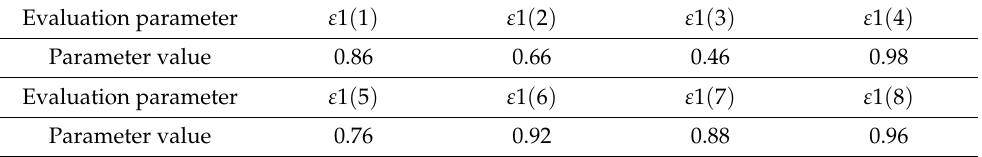
Table 1. Water scenic spot evaluation parameter.